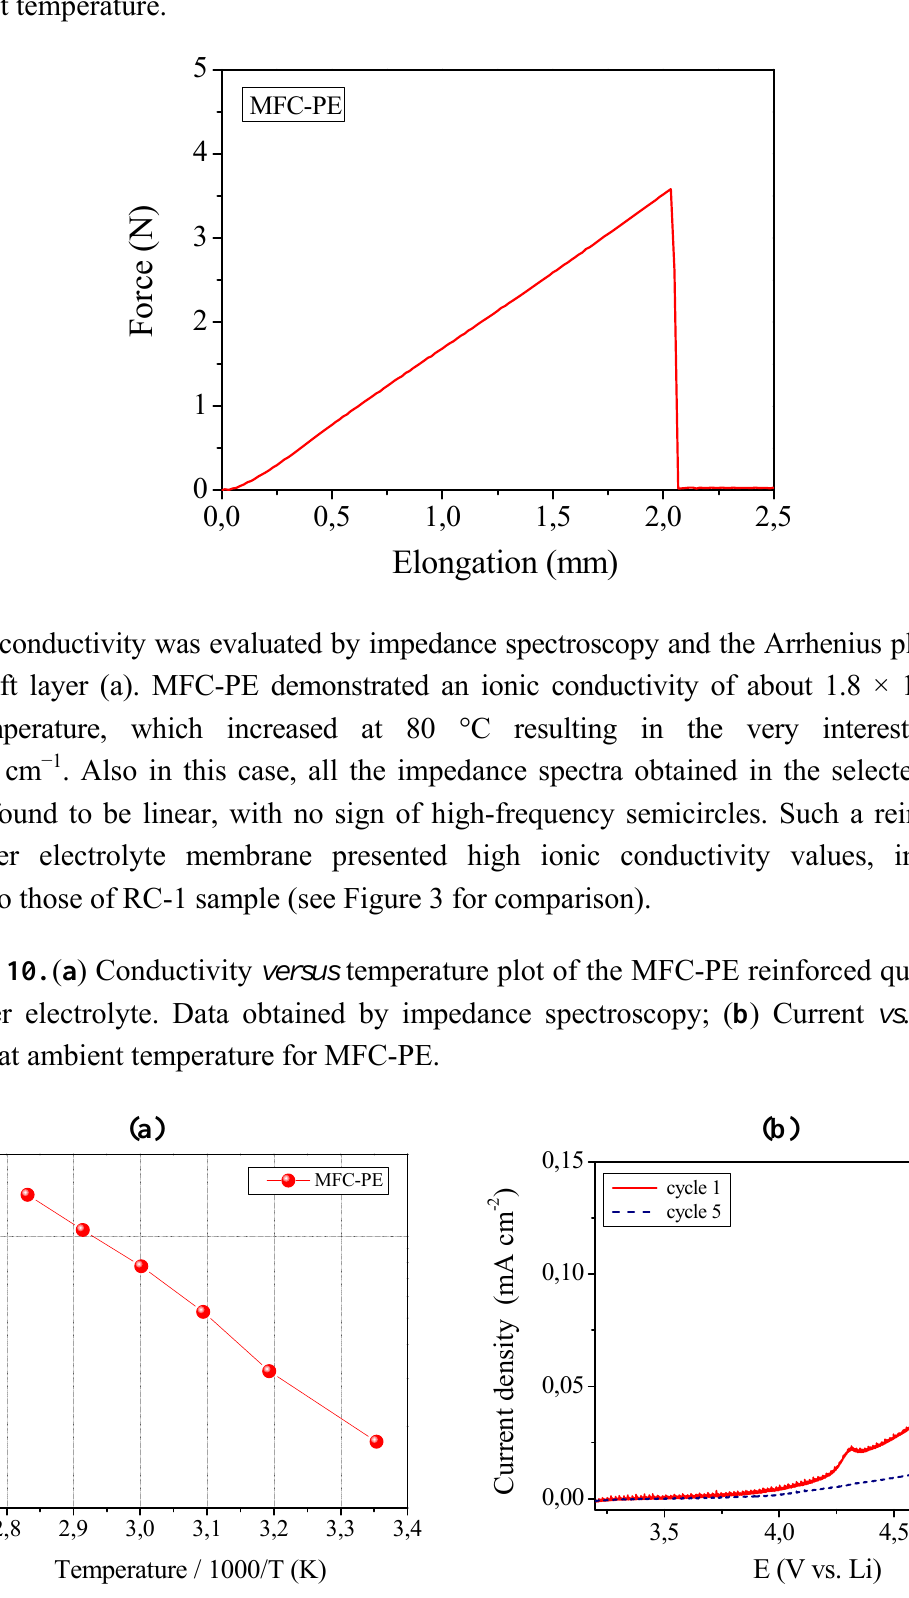
Figure 9. Mechanical measurements through traction test of the reinforced MFC-PE at ambient temperature.